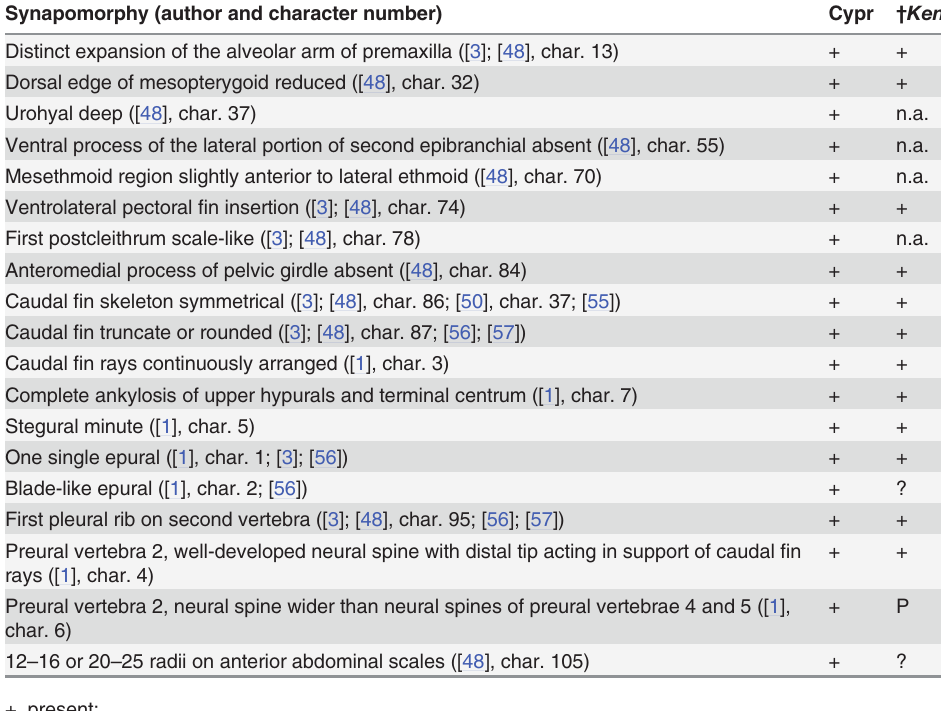
Table 5. Summary of the osteological synapomorphies for the Cyprinodontiformes and comparisons with † Kenyaichthys gen. et sp. nov. compiled from [1], [3], [48], [50], [56] and [57]. Synapomorphy (author and character number) Cypr † Ken Distinct expansion of the alveolar arm of premaxilla ([3]; [48], char. 13) + + Dorsal edge of mesopterygoid reduced ([48], char.